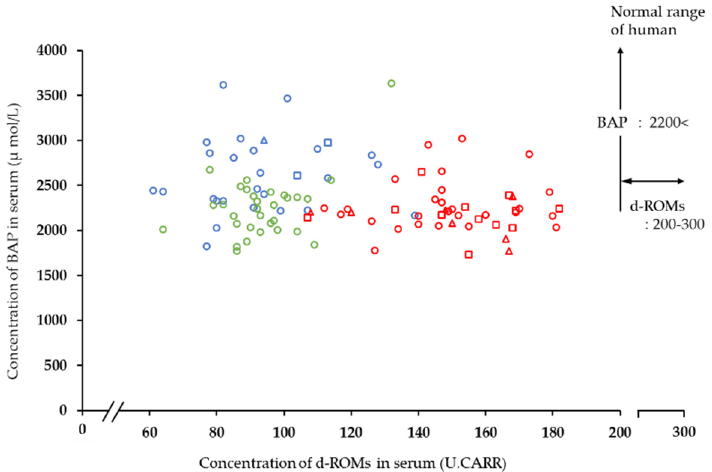
Figure 1. Comparison between diacron-reactive oxygen metabolite (d-ROM) and biological antioxidant potential (BAP) concentrations in serum of horses in an equestrian club in Shizuoka Prefecture and that of other animals (dairy cattle and dogs). Red symbols: horses in an equestrian club in Shizuoka Prefecture used in our study (circle: thoroughbred; square: pony; triangle: full-sized horses other than thoroughbred). Blue symbols: dairy cattle (circle: Holstein Friesian; triangle: Brown Swiss; square: Jersey). Green symbols: dogs.